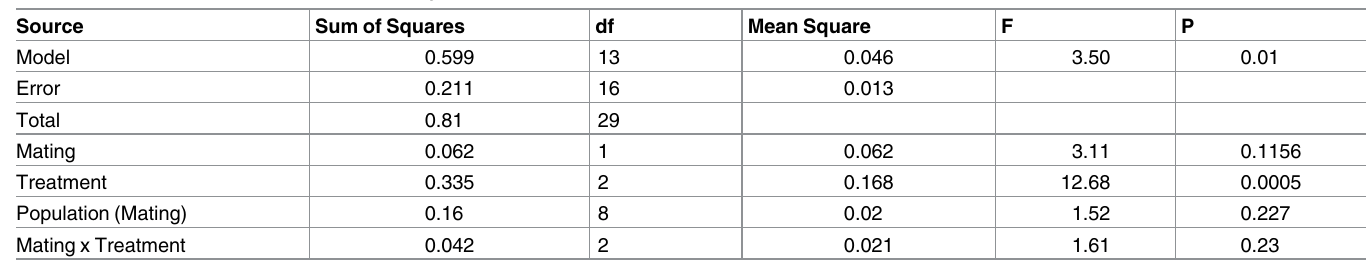
Table 2. ANOVA table for mean host mortality